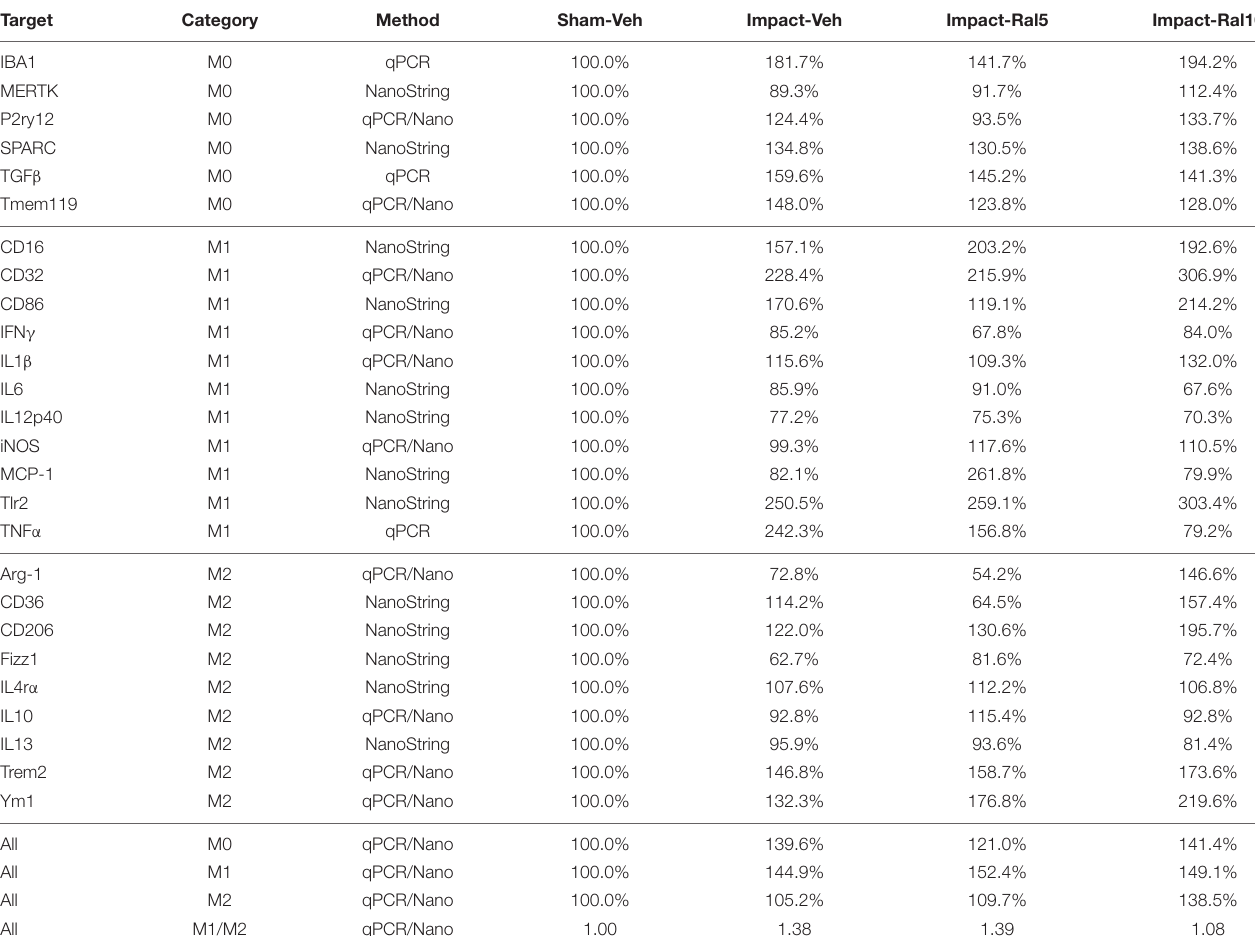
TABLE 3 | Expression of microglial transcripts in optic